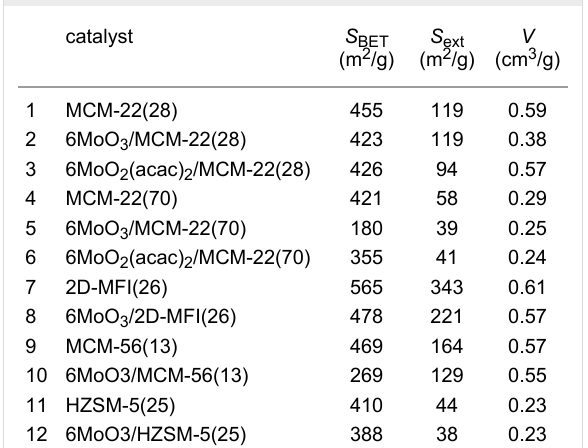
Table 1: Texture properties of catalysts and corresponding